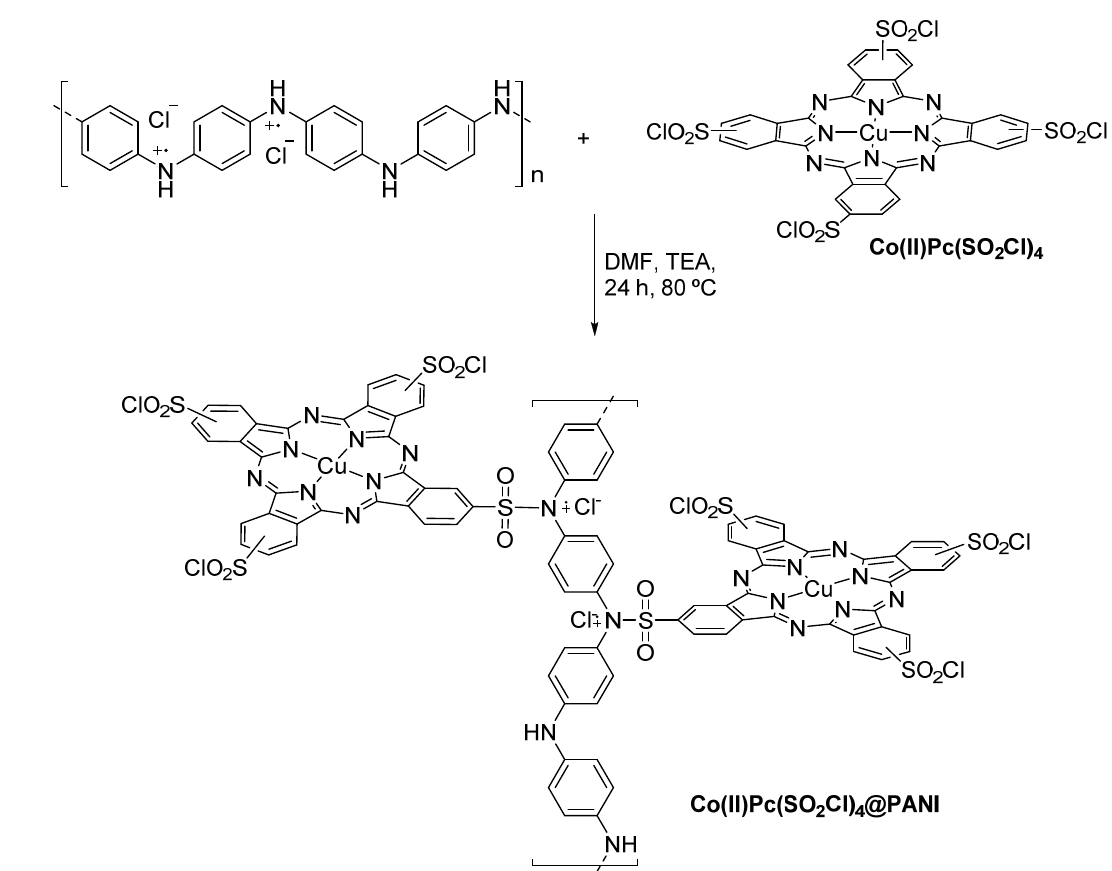
Figure 27. Structure and synthetic pathway to Co(II)Pc(SO 2 Cl) 3 SO 2 @PANI adapted from [76]). The heterogeneous catalyst Fe(II)Pc(CO 2 H) 3 CONH@NH 2 SBA-15 (Figure 28), obtained